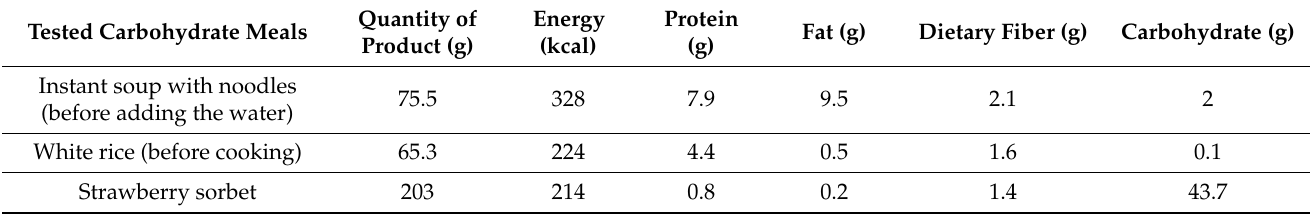
Table 1. The nutritional value of a tested foods serving providing 50 g of digestible